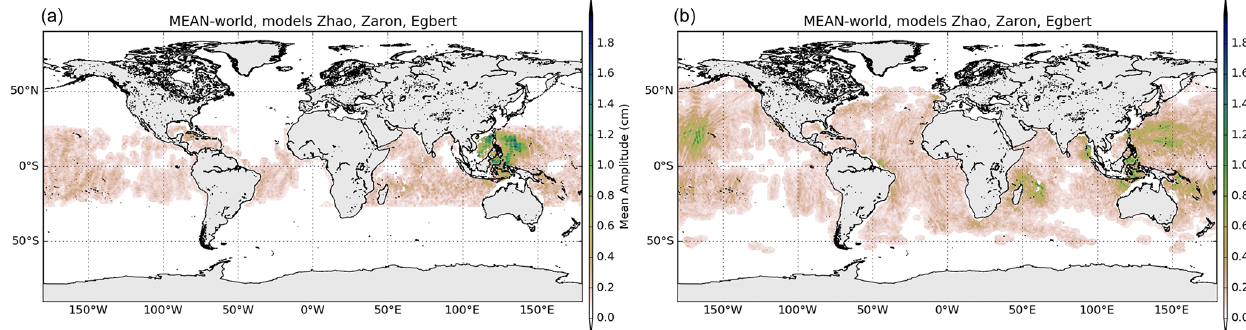
Figure A3. Global maps of mean amplitude of the O 1 (a) and S 2 (b) IT models (cm).